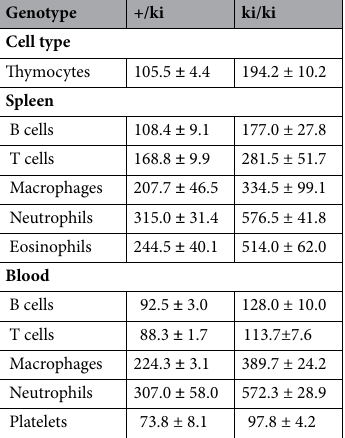
Table 1. MFI for indicated cell types of +/ki and ki/ki thymocytes, splenic and blood cells.